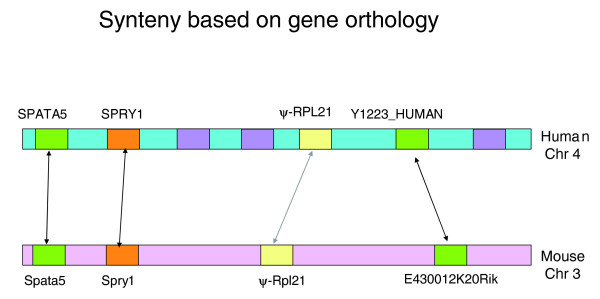
Schematic representation of the method used to identify syntenic regions between two species. In this figure, the pseudogenes are depicted as yellow boxes and human genes that have orthologs in mouse have been labeled. As explained in the text, the human gene SPRY1 and Y1223_HUMAN sandwich the processed RP pseudogene of RPL21 and have corresponding orthologs in the mouse genome. Thus, we identify this region as being syntenic between human and mouse. Orthologs were identified based on annotations from Ensembl release 36.